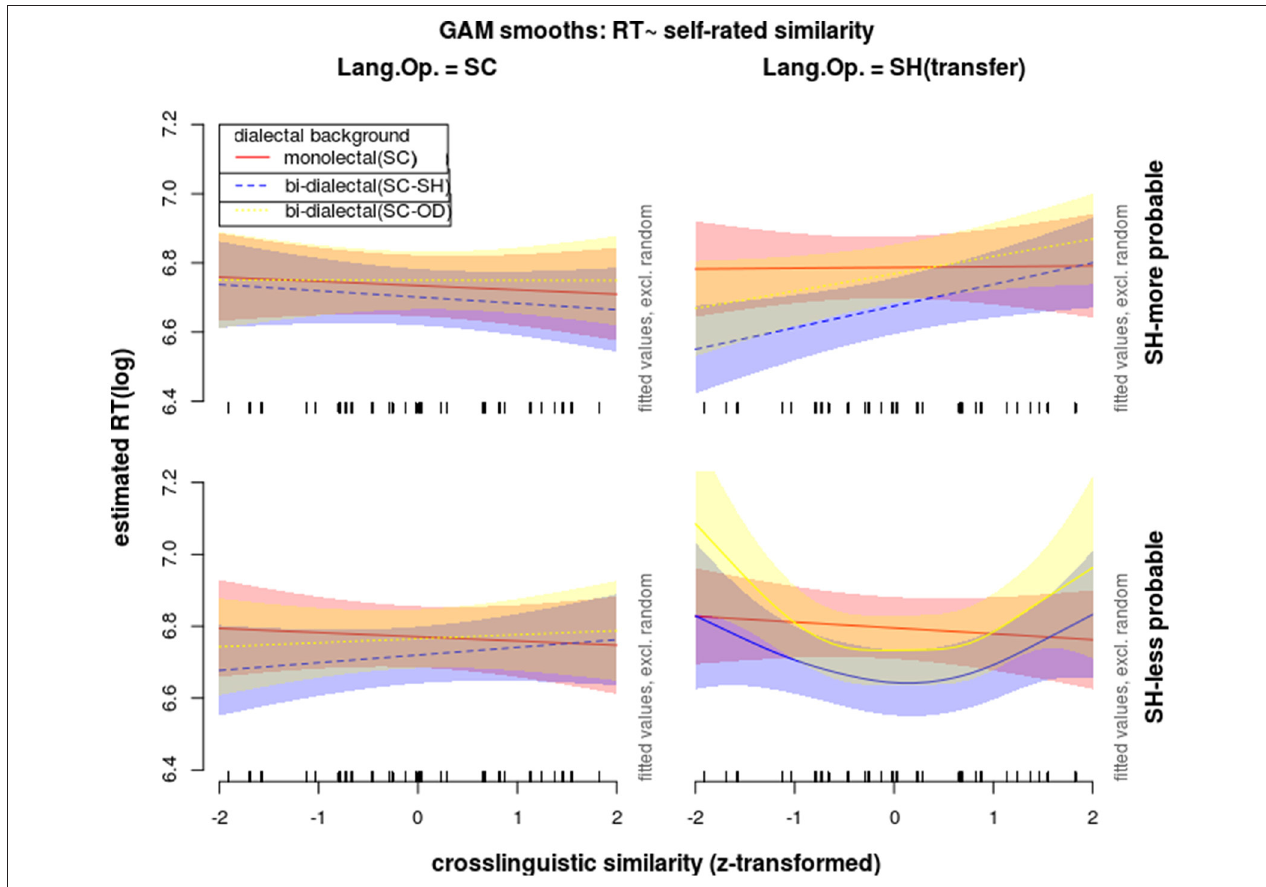
FIGURE 7 | Effects on reaction times in correct response to word trials during the lexical identification test, modeled with GAM, showing non-linear interactions of dialectal background (color), cross-dialectal similarity (along the vertical axes), the novel word’s morphological probability in SH (upper = high vs. lower = low subplots), and language of operation (left = SC vs. right = SH